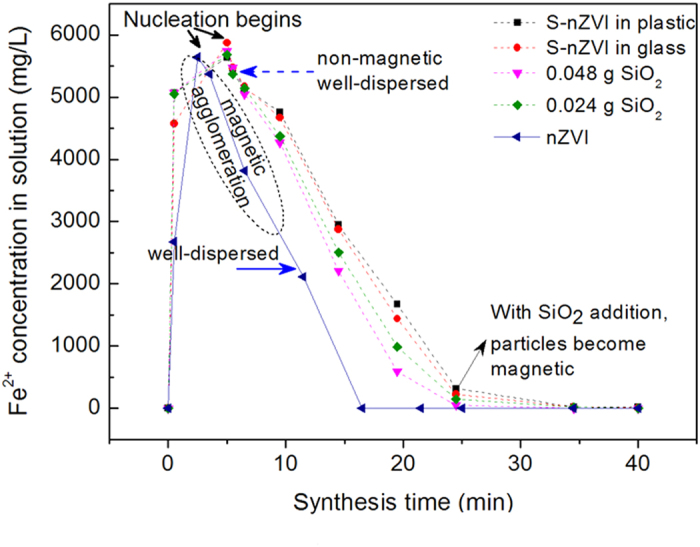
Fe2+ trend in FeCl3•6H2O solution during titration (all the collected samples were passed through a 0.22 um filter.